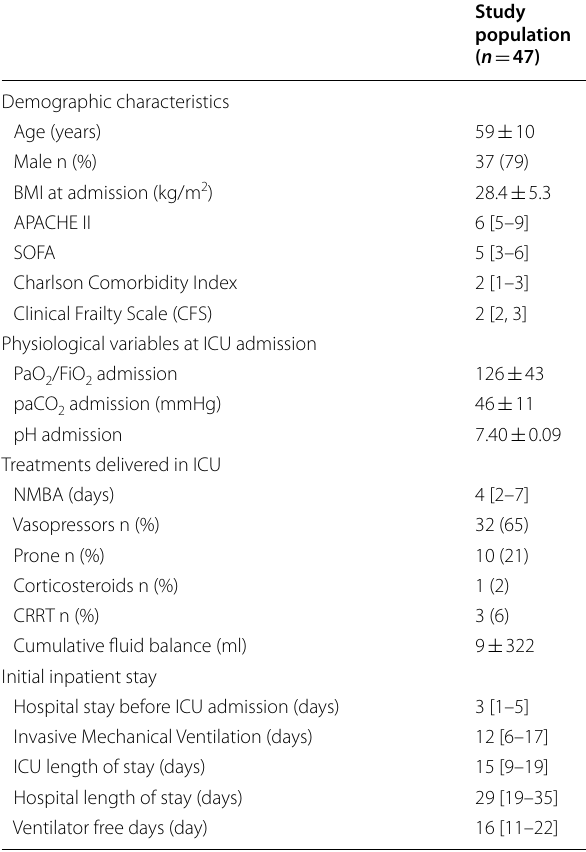
Table 1 Baseline